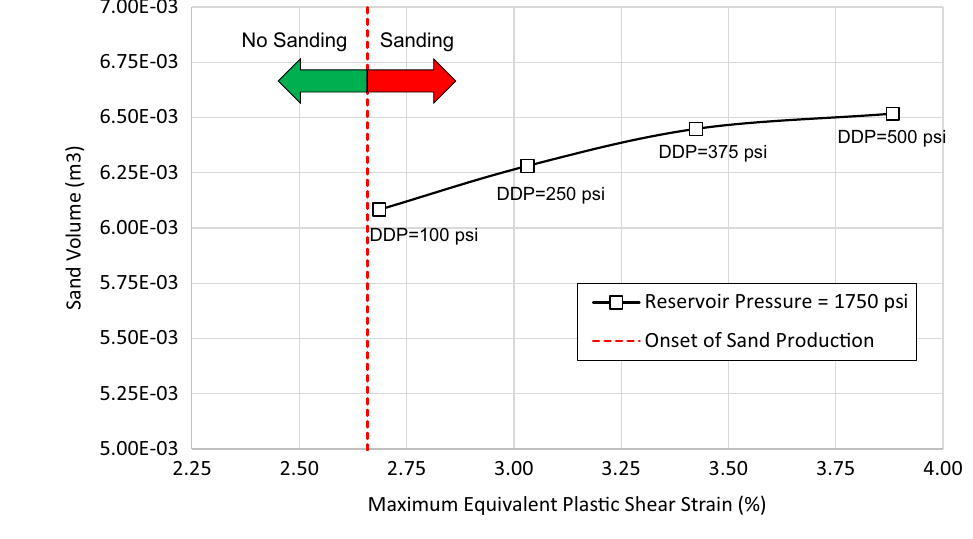
Fig. 30 Produced sand volume